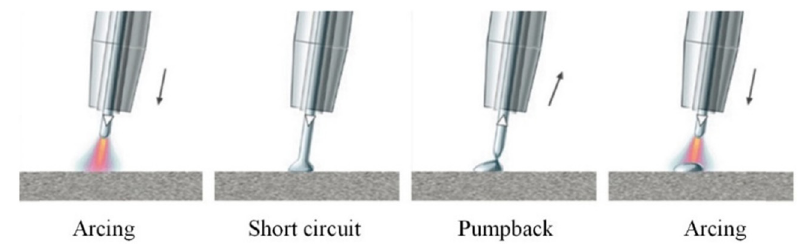
Figure 1: CMT droplet transition [ 17 ]